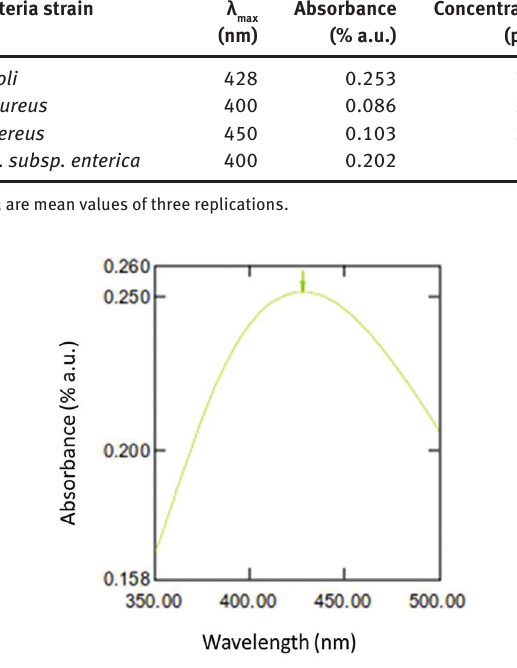
Figure 2: Surface Plasmon resonance spectrum of the synthesized Ag NPs using E. coli .